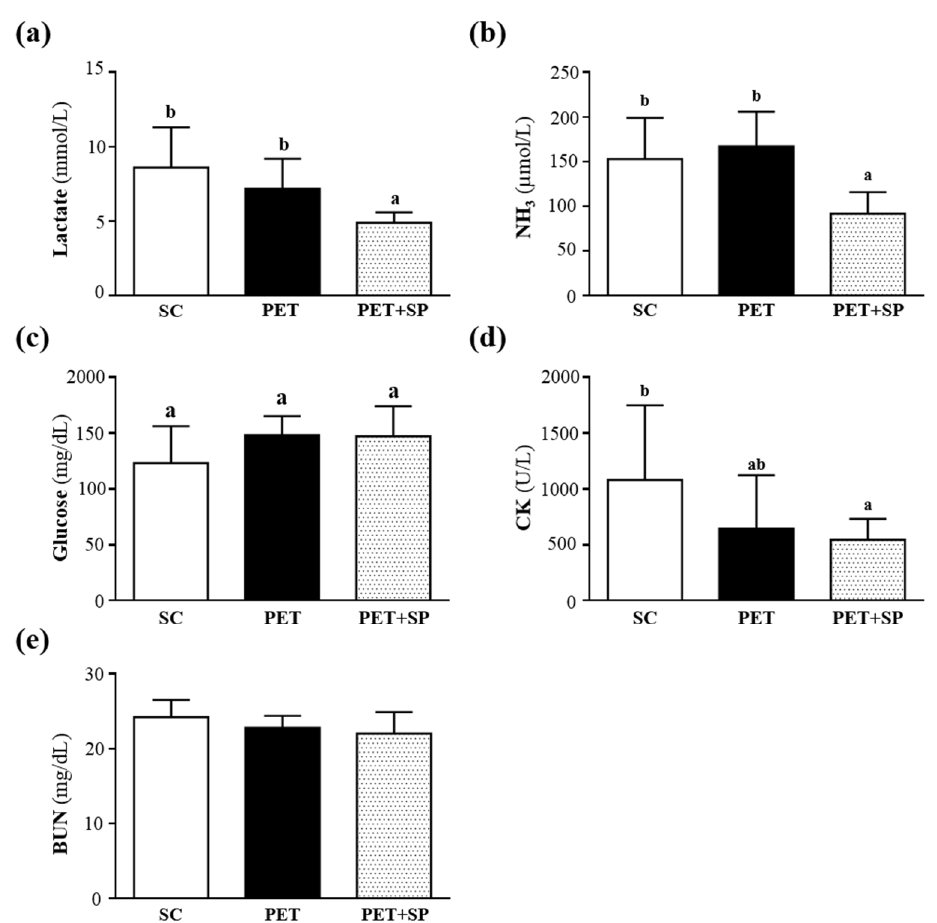
Figure 6. Effect of SP supplementation and four ‐ week PET on serum levels of ( a ) lactate, ( b ) ammonia, ( c ) glucose, ( d ) creatine kinase (CK), and ( e ) blood urea nitrogen (BUN) after an acute exercise challenge. Mice were pretreated with of SP for four weeks, then 1 h later performed a 15 ‐ min swimming test without weight loading. Data are mean ± SD of eight mice in each group. Columns with different letters (a, b) significantly differ at p < 0.05 by a one ‐ way ANOVA.